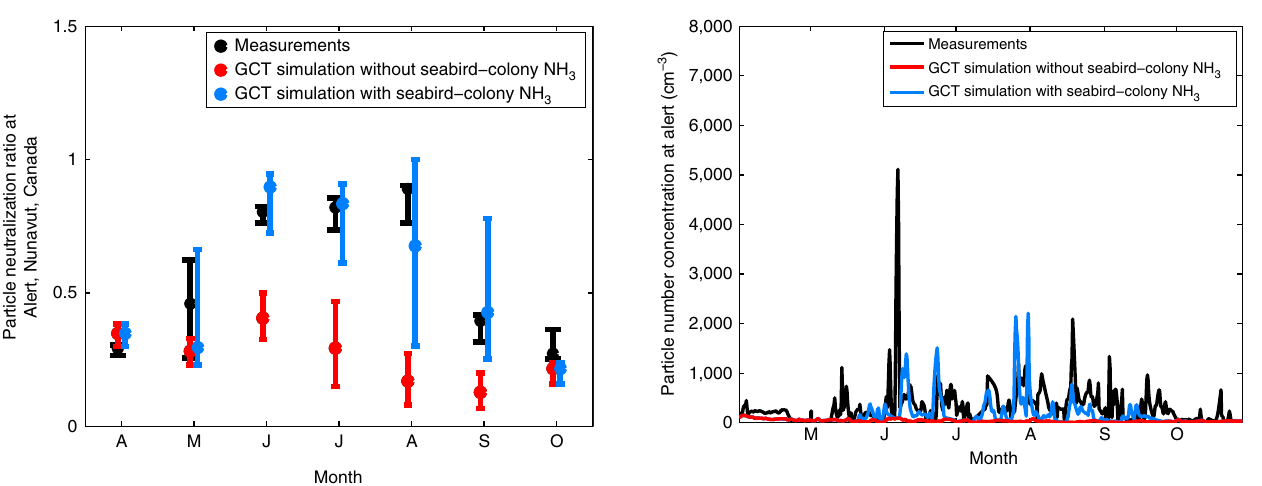
Figure 4 | Summertime bursts of newly formed particles at Alert. Time series of surface-layer number concentration of atmospheric particles larger than 10nm (N10) from condensation particle counter (CPC) measurements at Alert from April to October 2011 (black) and as simulated with GCT model, with (blue) and without (red) seabird emissions